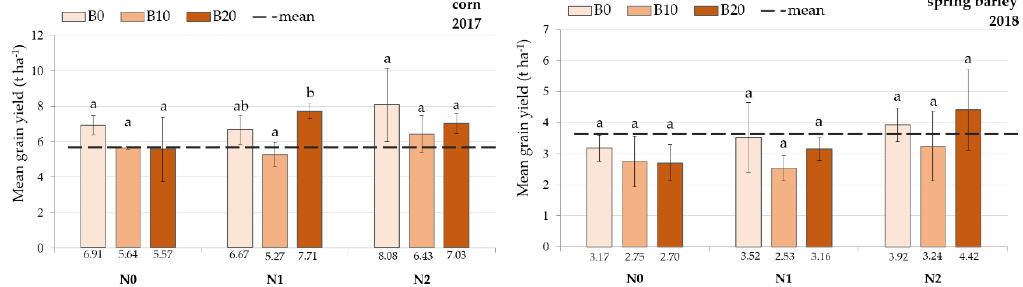
Figure 4. Effect of biochar and fertilizer application on the grain yield of maize in 2017 (fourth year after biochar application) and spring barley in 2018 (fifth year after biochar application) (means ± standard error; n = 3), in comparison to average crop yield (dashed line). Different letters indicate significant difference between treatments at the same fertilization level (N0, N1, N2) at p ≤ 0.05 according to the LSD multiple-range test.